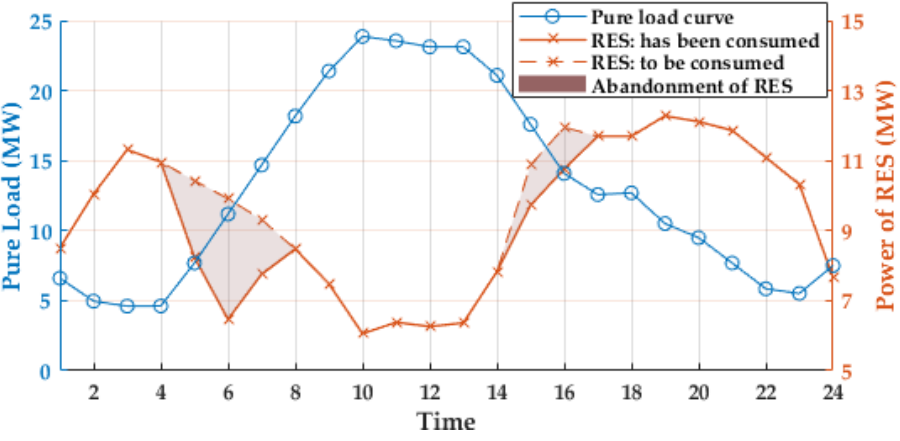
Figure 5. Conventional generation curve and RES curve through abandoning RES to get balance.